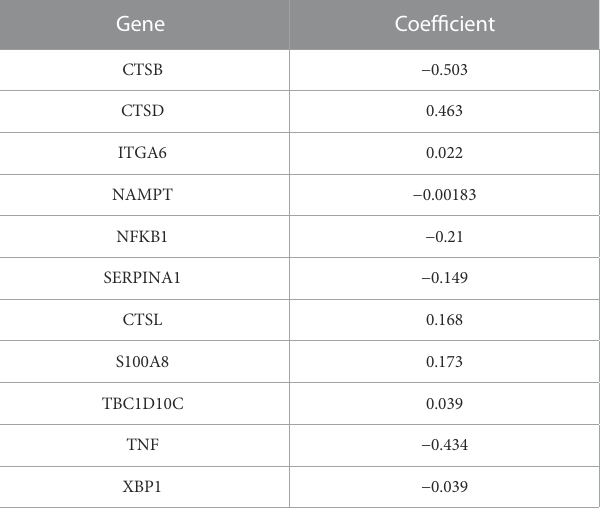
TABLE 1 Multivariate Cox regression analysis of 11 hug autophagy-related